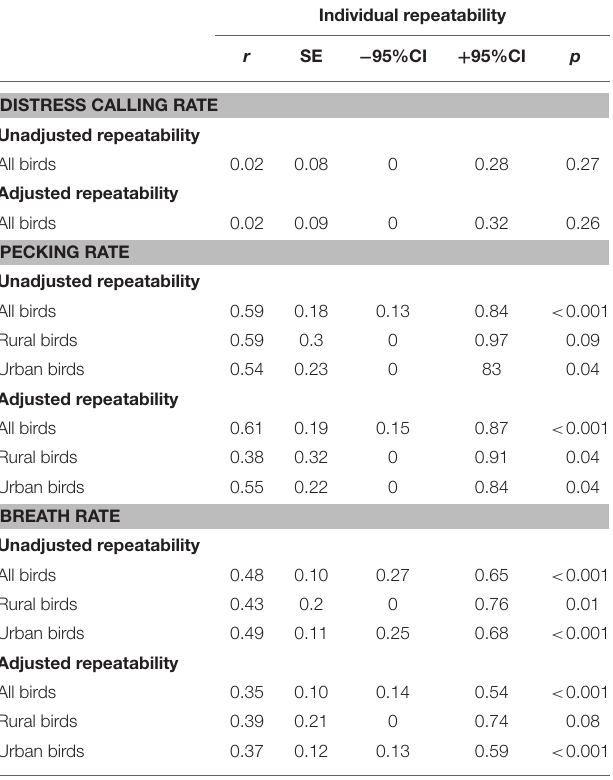
Individual repeatability